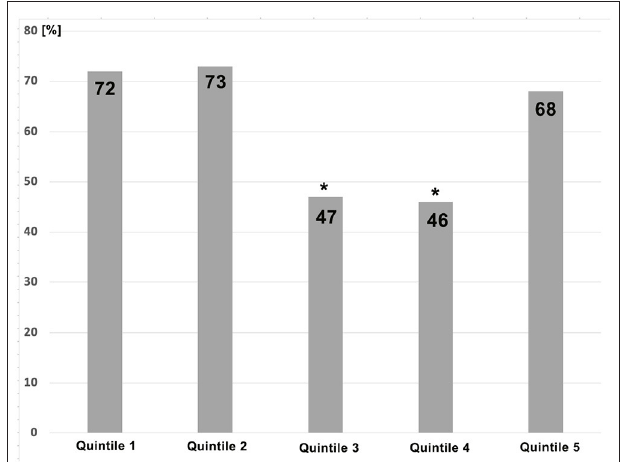
FIGURE 1 | The difference of prevalence of patients with functional mitral regurgitation who underwent transcatheter edge-to-edge mitral valve repair (M-TEER) over 5 quintiles. * p < 0.05 for the difference between quintile 3 and 4 and other